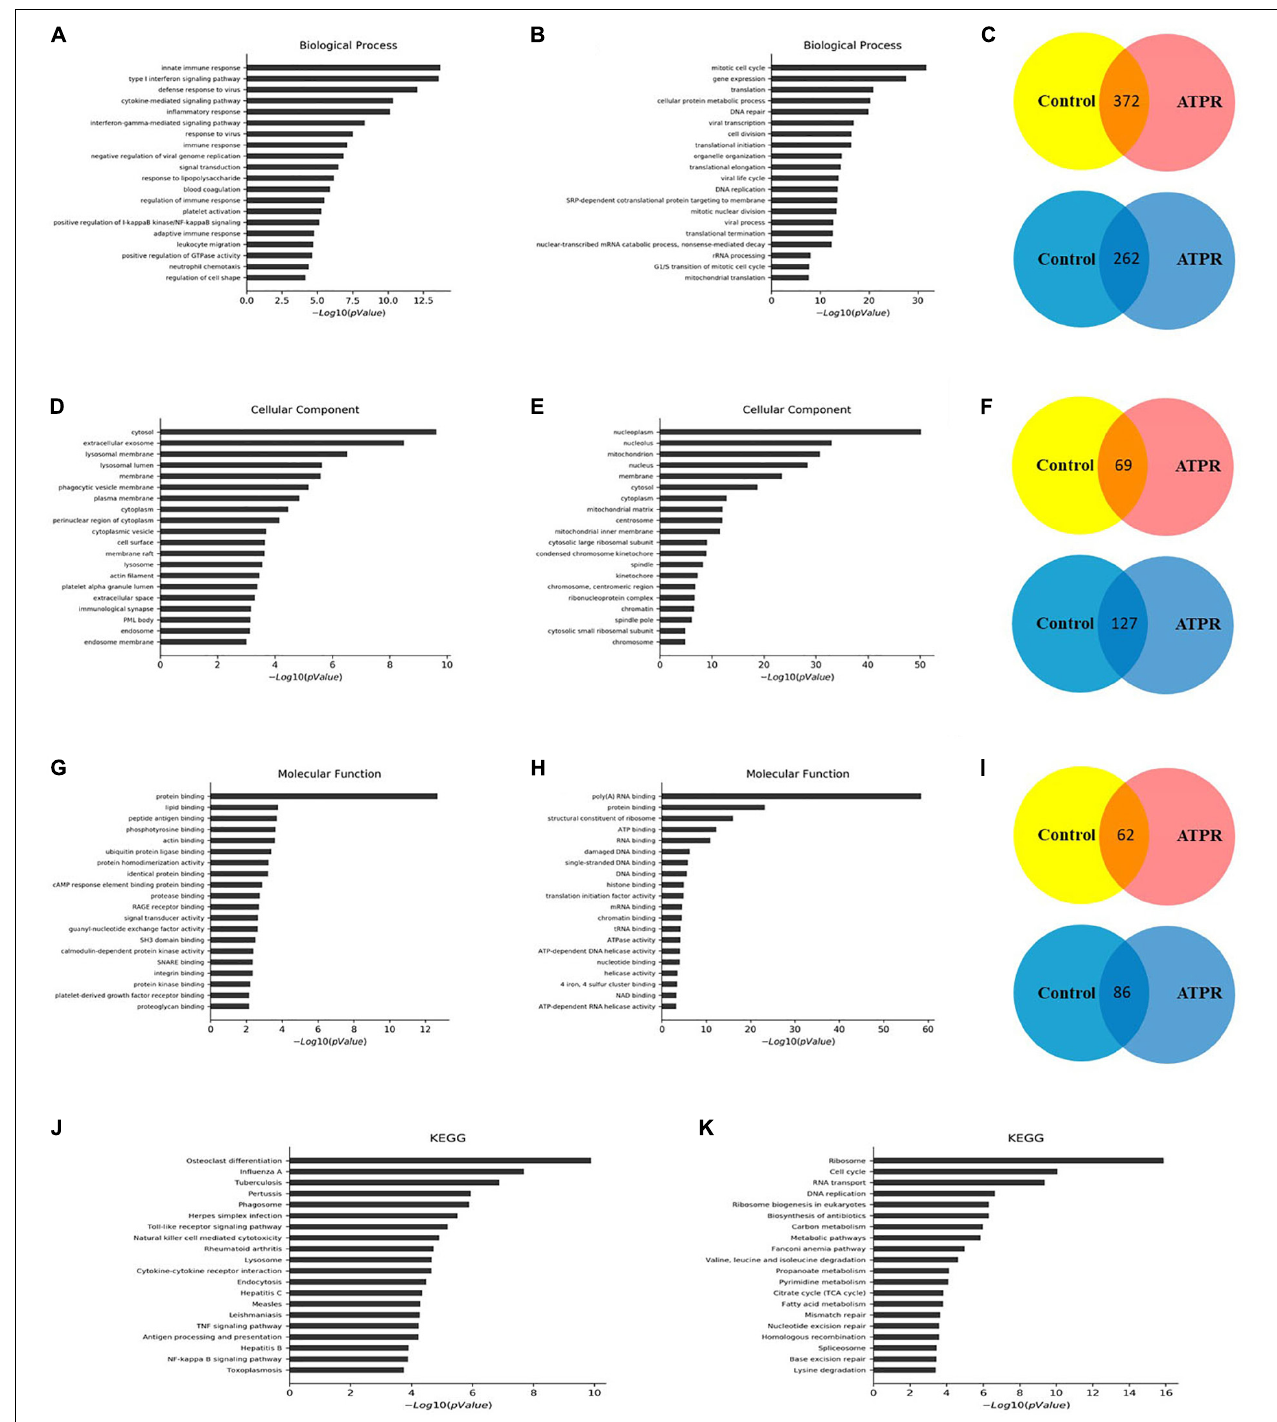
FIGURE 2 | GO and KEGG pathway analyses of the biological functions of genes co-expressed with differentially expressed lncRNAs. Top 20 upregulated (A) and downregulated (B) BP terms during ATPR regulated NB4 proliferation and differentiation ranked by enrichment score. (C) BP terms up- or downregulated throughout ATPR-regulated NB4 proliferation and differentiation. Top 20 up- (D) and downregulated (E) CC terms during ATPR-regulated NB4 proliferation and differentiation ranked by enrichment score. (F) CC terms up- or downregulated throughout ATPR-regulated NB4 proliferation and differentiation. Top 20 up- (G) and downregulated (H) MF terms during ATPR-regulated NB4 proliferation and differentiation ranked by enrichment score. (I) MF terms up- or downregulated throughout ATPR-regulated NB4 proliferation and differentiation. Top 20 upregulated (J) and downregulated (K) pathways.